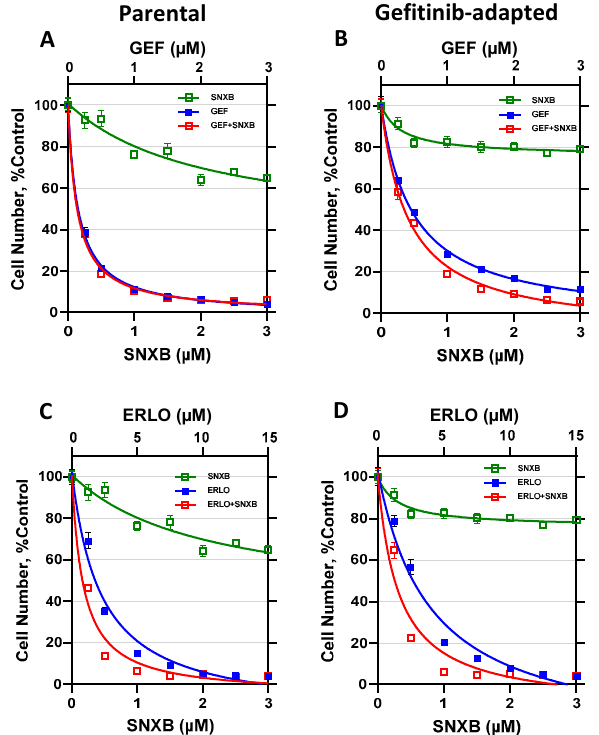
Figure 4. Effects of gefitinib and erlotinib alone and in combination with senexin B in parental and gefitinib-adapted SKBR3 cells. ( A , B ). Effects of 7-day treatment with gefitinib and senexin B, alone